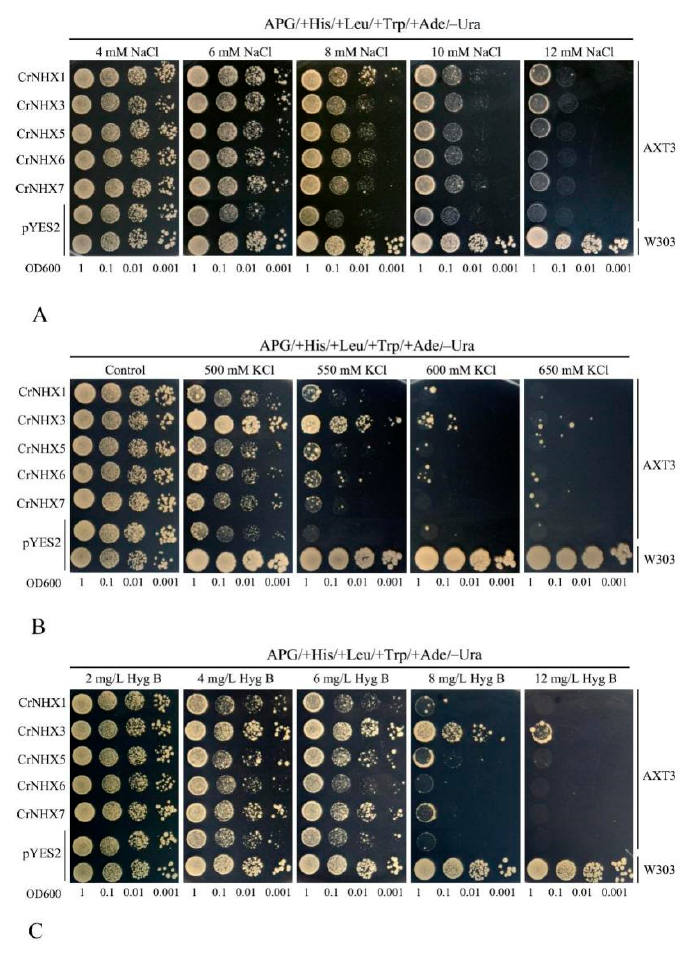
Figure 10. Complementation of yeast mutants on solid medium containing different concentrations of stress factors. The yeast wild-type strain W303 was transformed with the empty vector pYES2, and the triple-mutant strain AXT3 was transformed with the empty vector pYES2 or with the vectors carrying the CrNHX genes. Yeast cultures were adjusted to OD600 = 1, and 2 μ L of serial dilutions (10-fold, from left to right in each panel) were spotted on SC-U/Gal medium supplemented with different concentrations of NaCl ( A ); KCl ( B ); and hygromycin B ( C ). The plates were incubated for 2–4 days at 30 °C. The images are representative of three independent experiments.